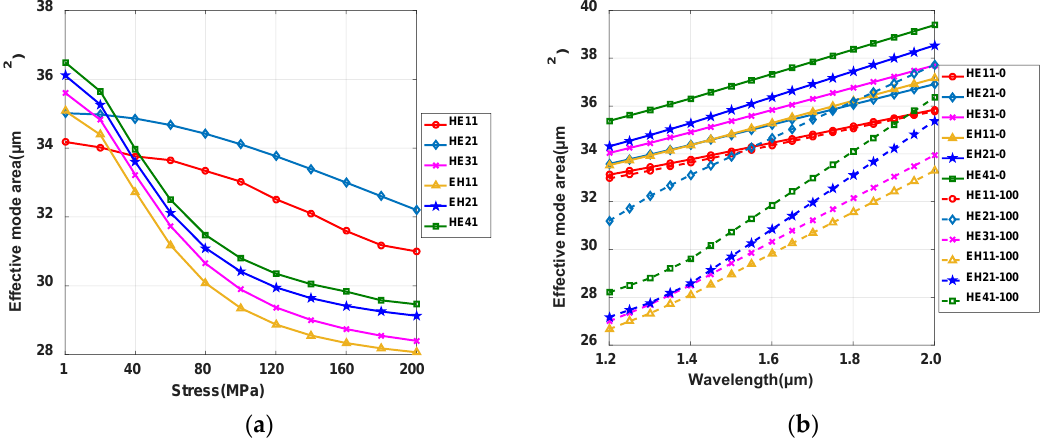
( b ) Figure 16. ( a ) Nonlinear parameter as a function of stress for different modes, and ( b ) nonlinear parameter as a function of wavelength for different modes under 100 MPa stress in the y direction.